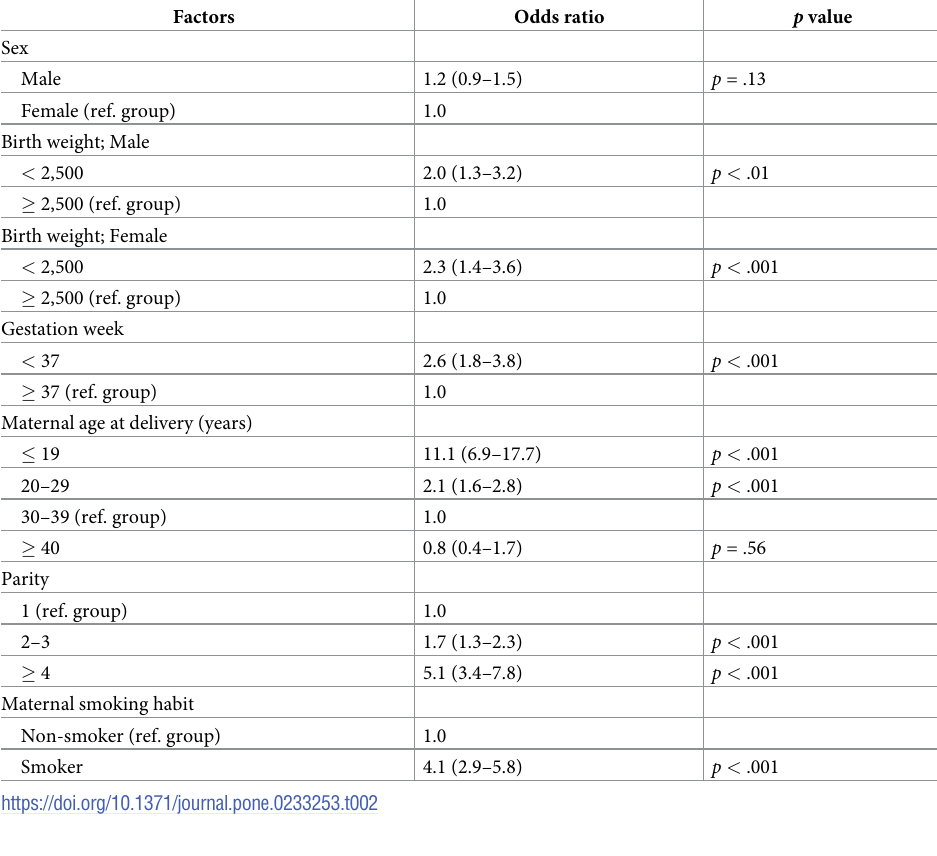
Table 2. Odds ratios (95% CI) and p values of SUDI cases to population